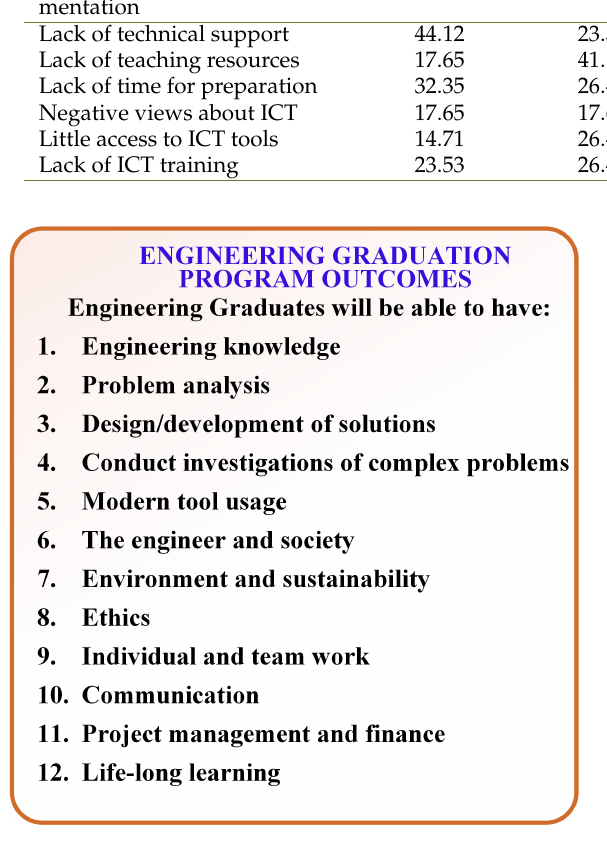
Fig. 4. List of PO’s recommended by